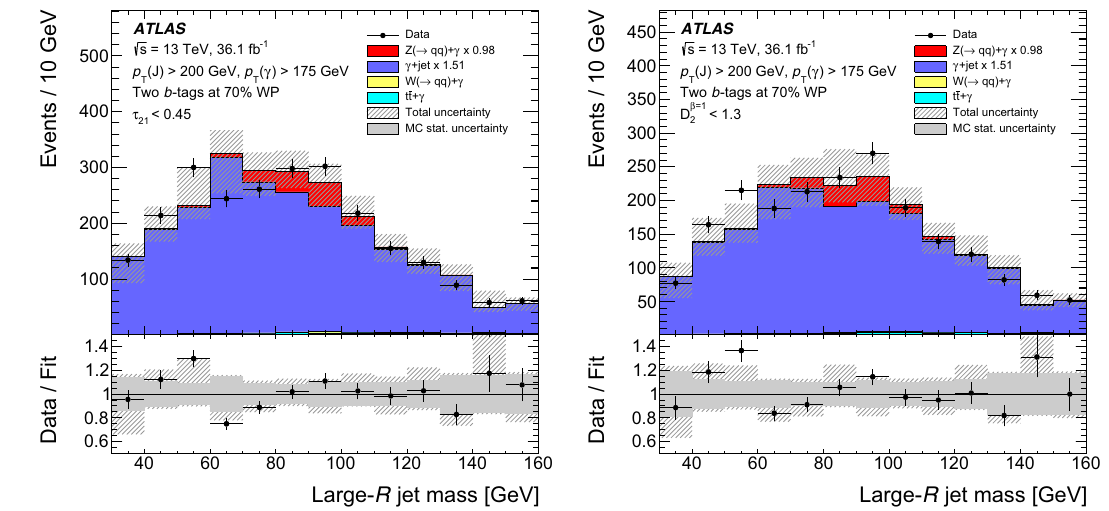
β = 1 < 1 . 3 (right) requirement. Events with two b -tagged track-jets 2